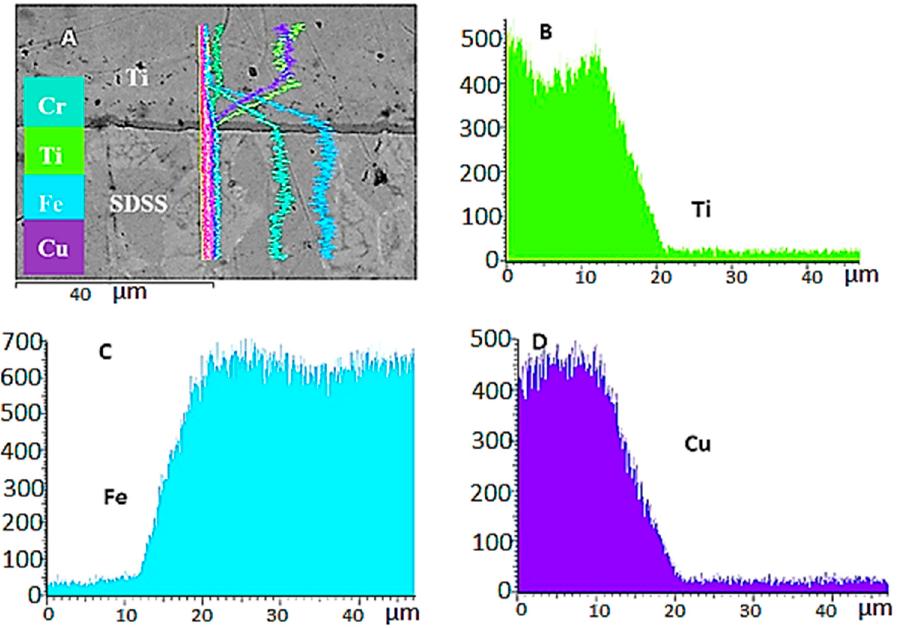
Figure 8. ( A ) SEM micrograph of a region on the Ti–6Al–4V and SDSS joint bonded at 850 °C for 45 min with Cu/Al 2 O 3 coating. EDS line scanning analysis of elements ( B ) Ti, ( C ) Fe, and ( D ) Cu.